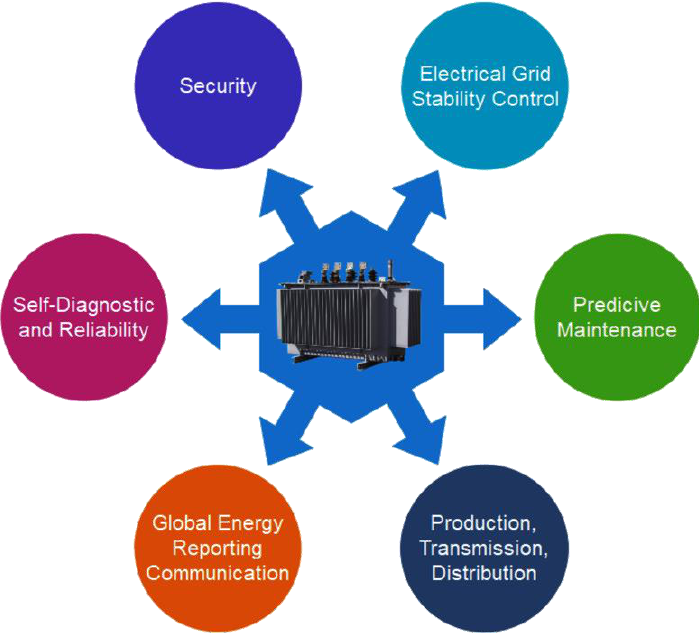
Figure 1. Smart power transformer features.